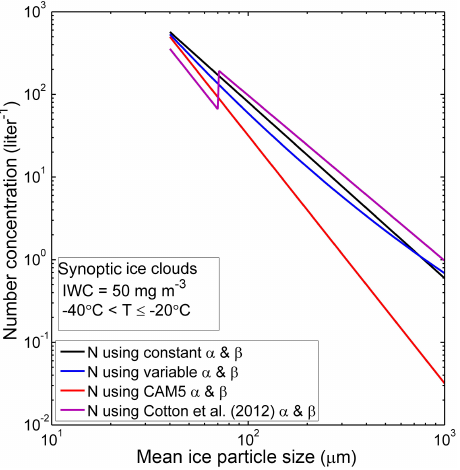
Figure 13. Dependence of the D e on D using the three methods indicated for determining α , β , γ , and δ . The black and blue curves use the m - D curve fit based on Table 1 and A - D curve fit based on Table 2 for the indicated temperature range, with the black curve α,β,γ , and δ evaluated at D =